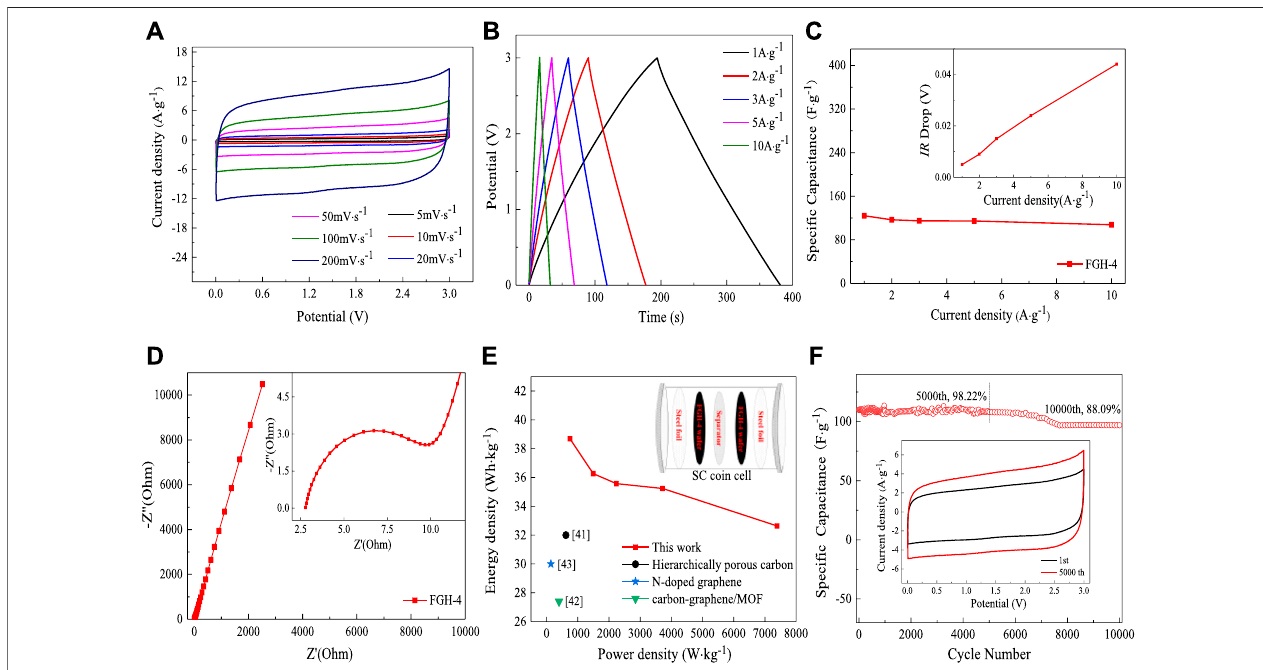
FIGURE 7 | (A) CV curves for the FGH-4 coin cell at different scan rates, (B) GCD curves of the FGH-4 coin cell at different current densities, (C) the gravimetric speci fi ccapacitanceandtheIRdropcurves(inset)oftheFGH-4coincellatdifferentcurrentdensities, (D) EIScurvesoftheFGH-4coincell, (E) RagoneplotsoftheFGH- 4 coin cell, and (F) cycling performance of the FGH-4 coin